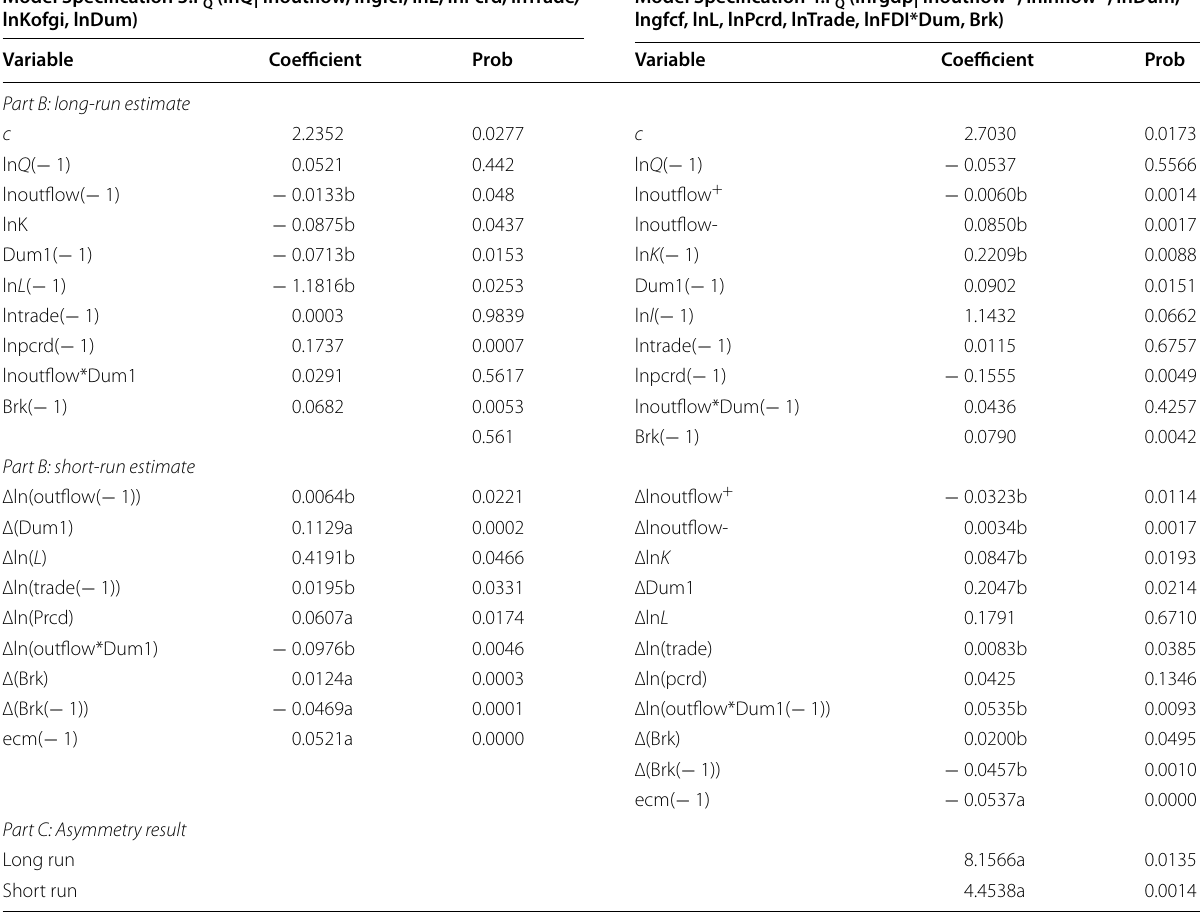
a and b Indicate 1% and 5% level of